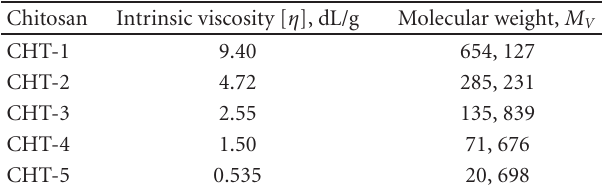
Table 2: Intrinsic viscosity and viscosity average molecular weight of di ff erent grades of